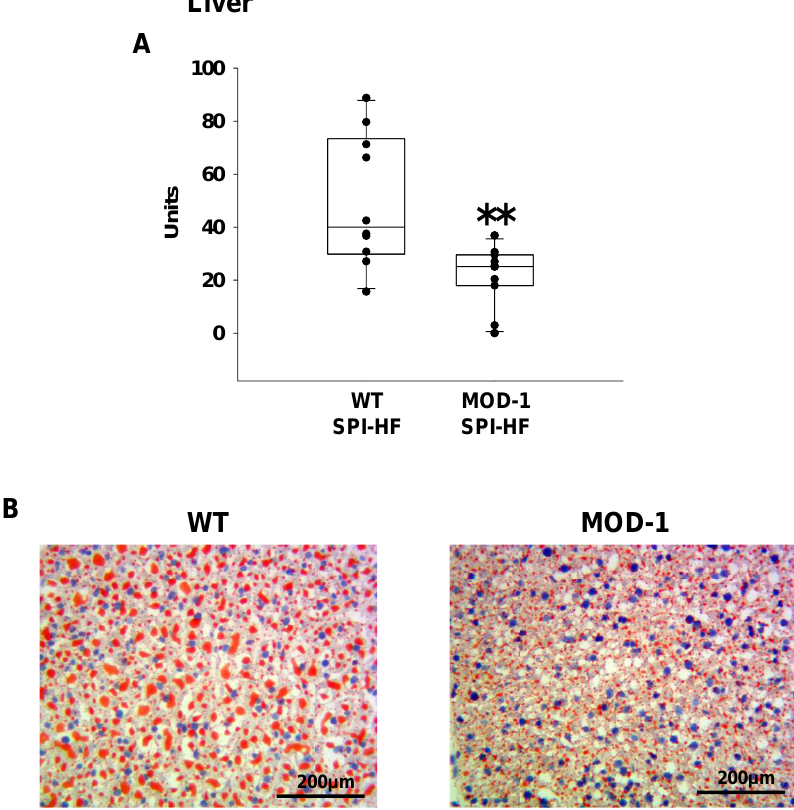
Figure 9. Lipid bodies in mouse livers were visualized and quantified by staining thin sections with Oil Red O, using previously described procedures [6,26]. ( A ) Oil Red O staining intensity was quantified using Aperio ImageScope (Version 12.3); n = 10 WT and n = 11 MOD-1 mice. ** p < 0.01. ( B ) Representative section (Oil Red O-stained) from a liver of one female mouse of each genotype.